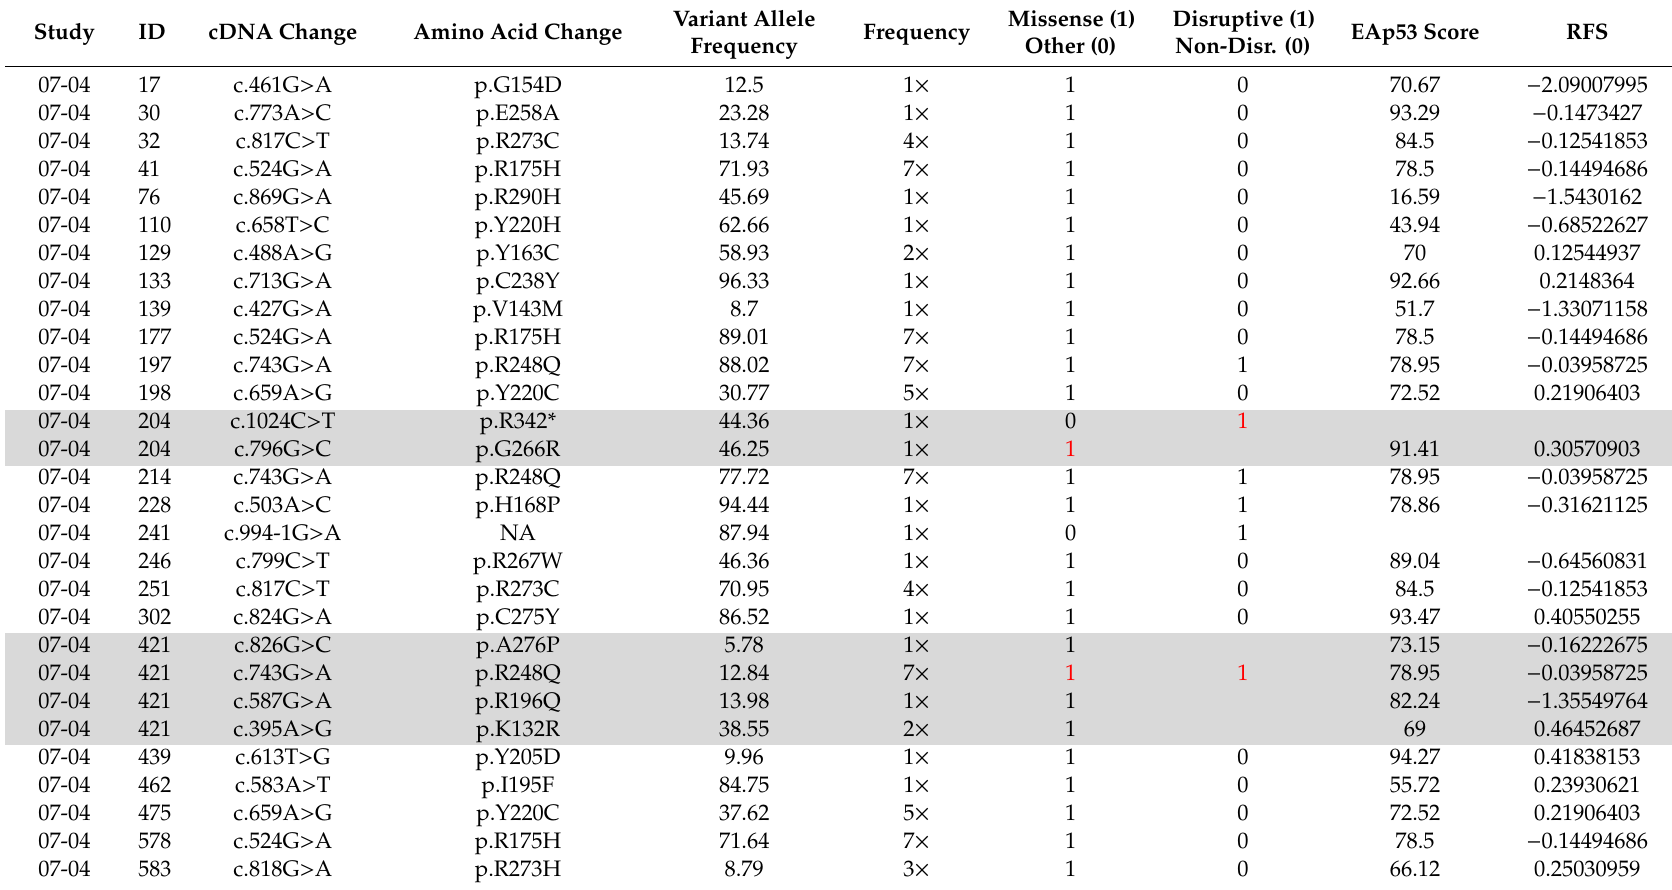
Table 1. Characteristics of TP53 mutations found in AMLSG patients and their assessment in di ff erent scoring systems. In the 8 patients with more than one TP53 mutation (marked in grey), the mutation used for analysis is depicted in red. Abbreviations: non-disr., non-disruptive mutations; EAp53 Score, Evolutionary Action p53 Score; RFS, Relative Fitness Score; NA, not applicable; “other” refers to nonsense and splice site TP53 mutations, as well as to small insertions and deletions. “Frequency” refers to the cohort